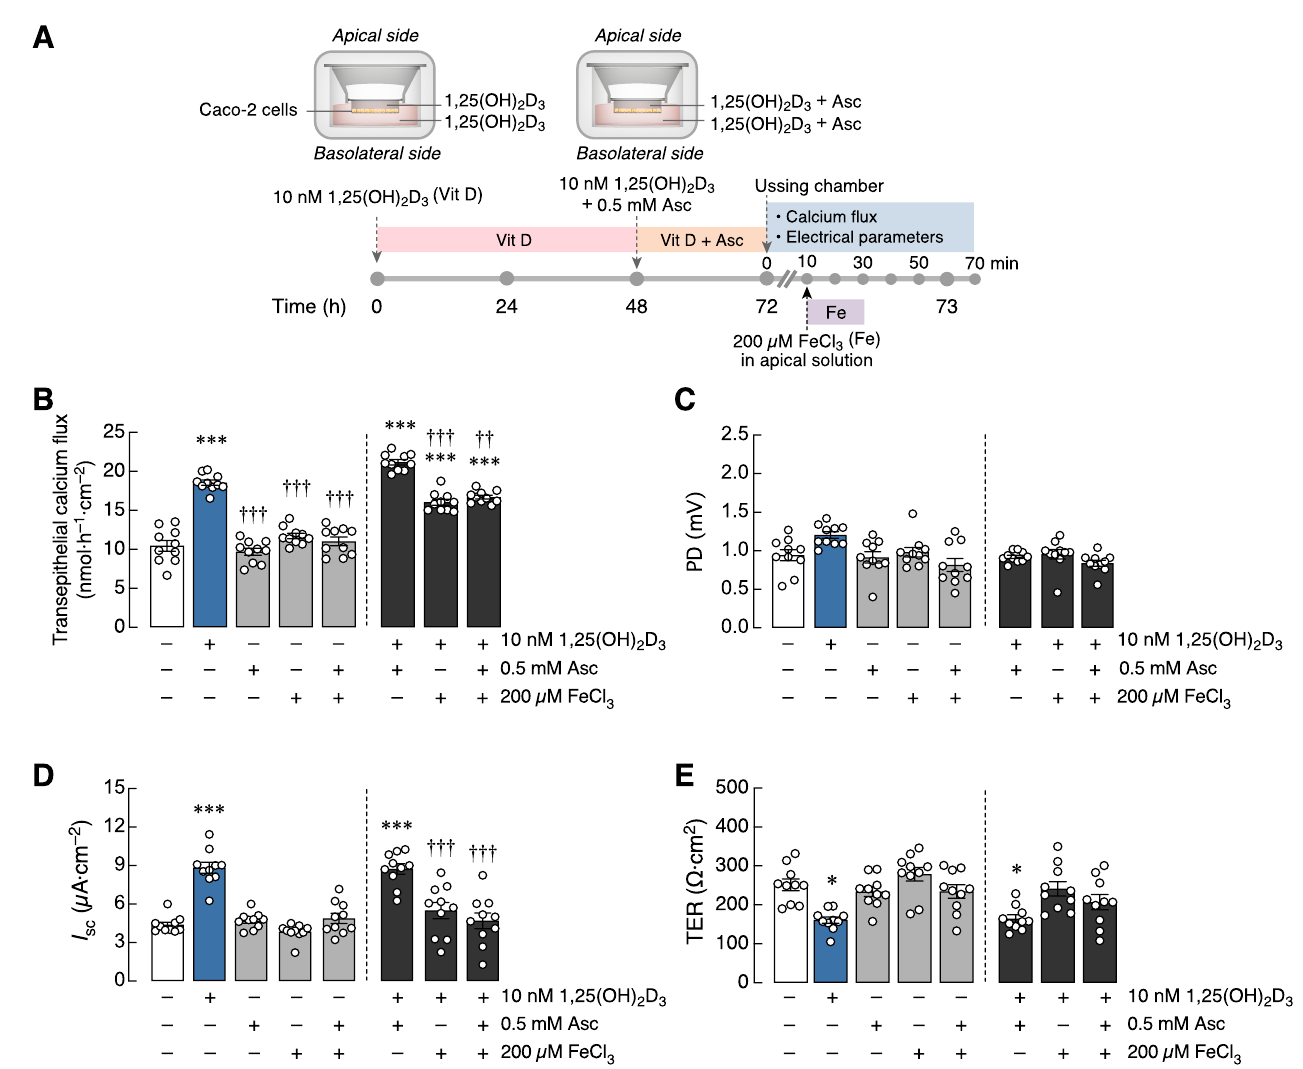
Fig 3. The role of FeCl 3 on calcium transport across Caco-2 monolayer pre-treated with 1,25(OH) 2 D 3 and ascorbic acid (Asc). (A) Experimental timeline (please see text for detail). (B–E) Transepithelial calcium transport and epithelial electrical parameters (PD, I sc , and TER) in Caco-2 monolayers with or without 10 nM 1,25(OH) 2 D 3 , 200 μ M FeCl 3 , and 0.5 mM Asc. PD values were the magnitudes of potential difference (the apical side being negative with respect to the basolateral side), and glucose made the apical side more negative. (n = 10; � P < 0.05; ��� P < 0.001 compared with the control group (white bar); †† P < 0.01, ††† P < 0.001 compared with the 10 nM 1,25(OH) 2 D 3 -treated group (blue